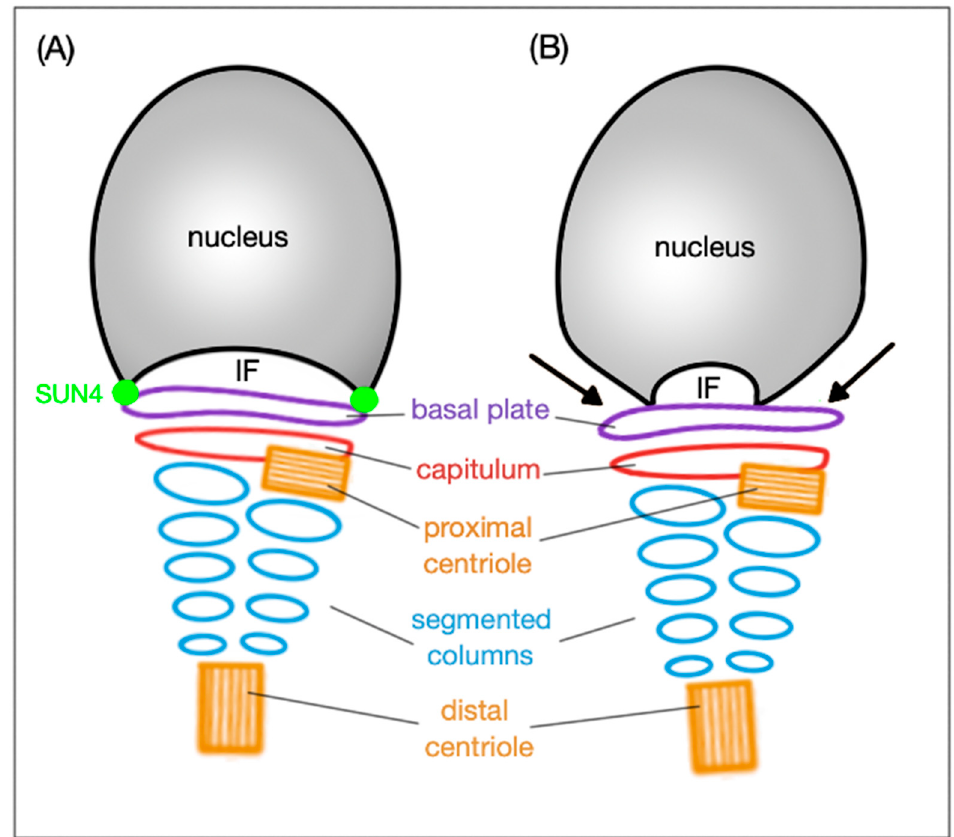
Figure 3. Schematic representation of the HTCA arrangement and the SUN4 significance. ( A ) In wild type, the basal plate is tightly attached to the implantation fossa (IF) thanks to the SUN4 protein. ( B ) When SUN4 is missing, the lateral regions of the basal plate are clearly detached (indicated by black arrows) from the IF; the arrangement of HTCA remains intact under both circumstances.